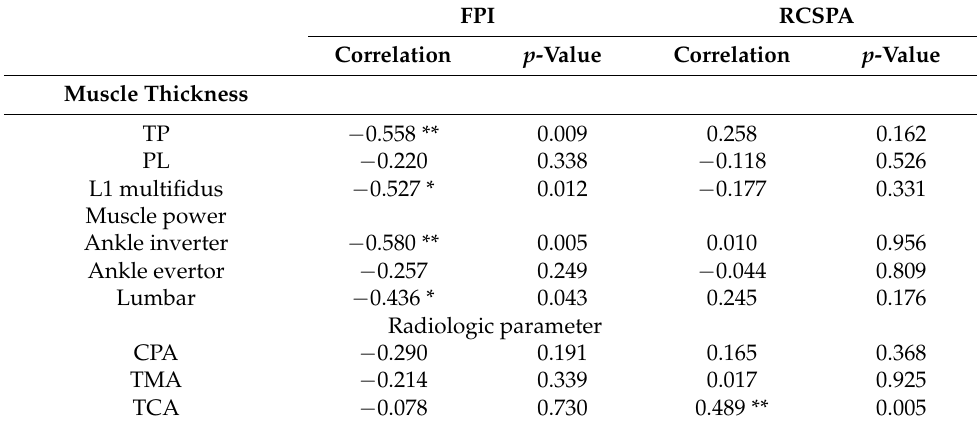
Table 6. Correlation between clinical parameters and muscle thickness, muscle power, and the radiologic parameters for all participants (n =